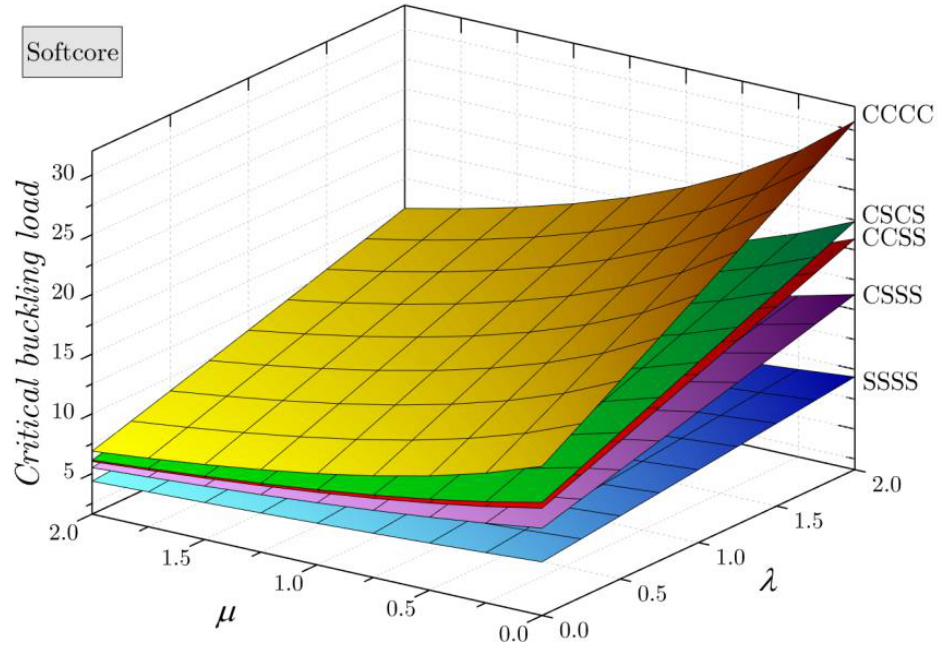
Figure 11. Effect of the nonlocal and length-scale parameters for various boundary conditions ( FG − A , R = 5, p = k = e = 2, b = a = 10 h , µ = λ = G ζ = G η = K w = 0